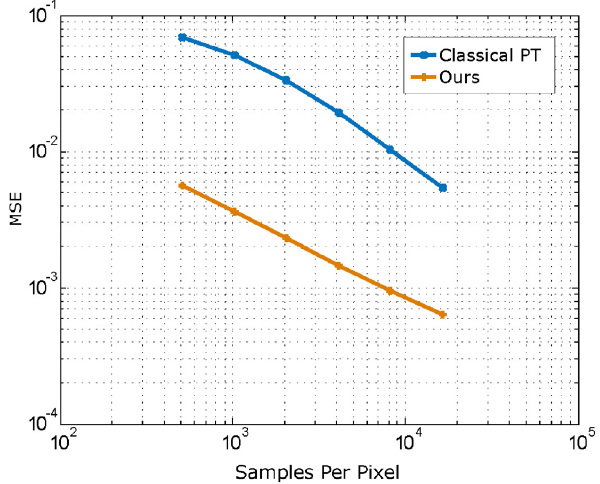
Fig. 17 Error (MSE) for our method and path tracing, as a function of the sample count per pixel, for the Candle scene.